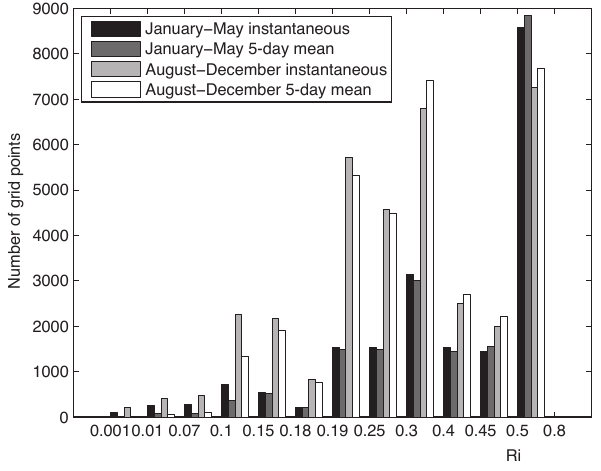
Fig. 9. Number of grid points at 41.20m (model level three) with values of the Richardson number within the interval shown (see leg-